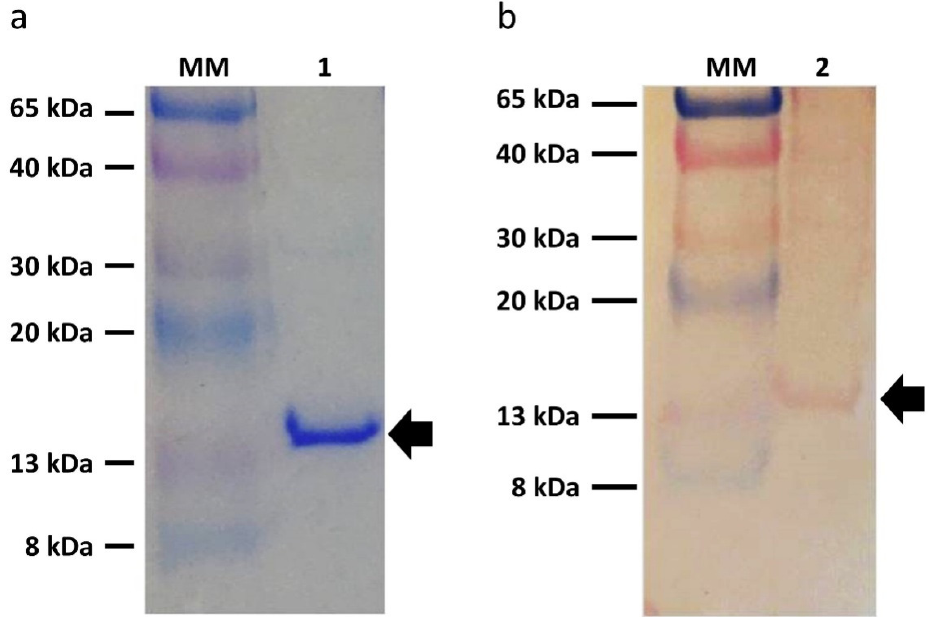
Figure 3. Characterization of ZIKV-EDIII. ( a ) SDS-PAGE 1: ZIKV-EDIII. ( b ) Western Blot. 2: ZIKV- EDIII. Arrows indicate recombinant protein.MM: molecular weight marker (Color burst TM Electrophoresis Marker—Sigma).